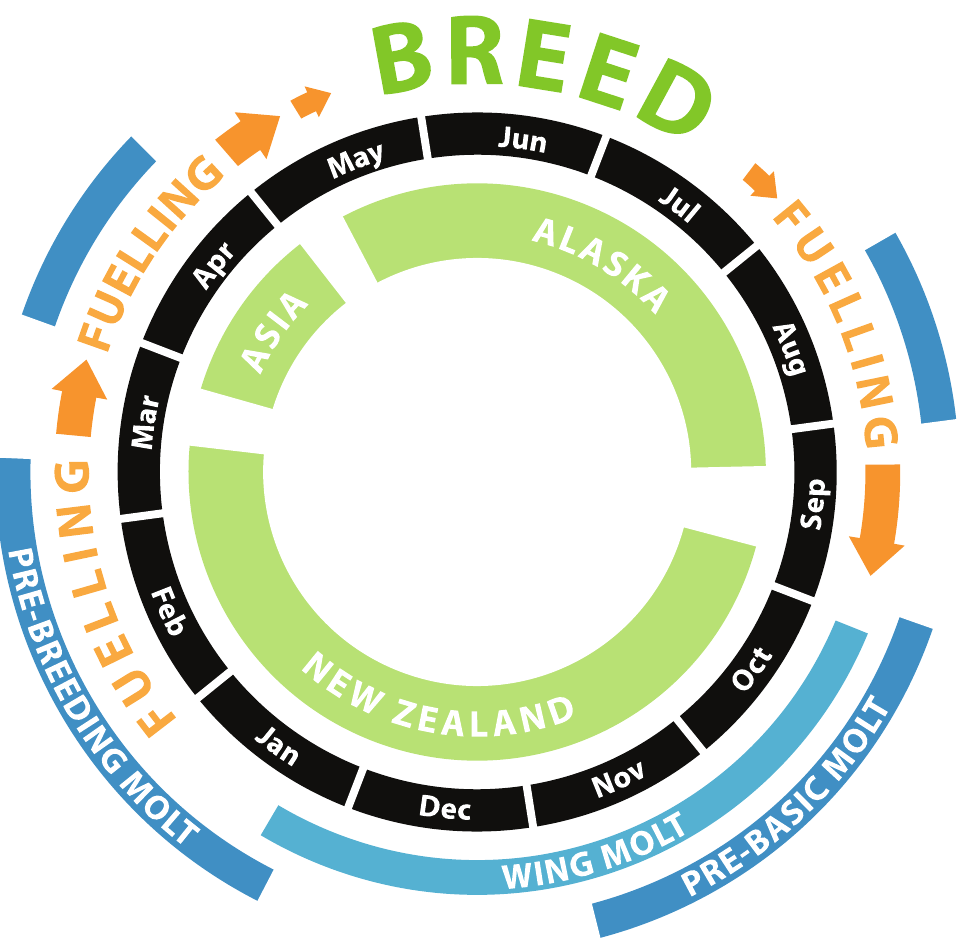
Figure 1. Generalized cycle of annual life-history stages of New Zealand bar-tailed godwits. Typical adult male routine is shown. Large arrows indicate major migratory flights. Smaller arrows indicate movements within Alaska. Pre-basic and pre-breeding contour molts are suspended during migratory flights.